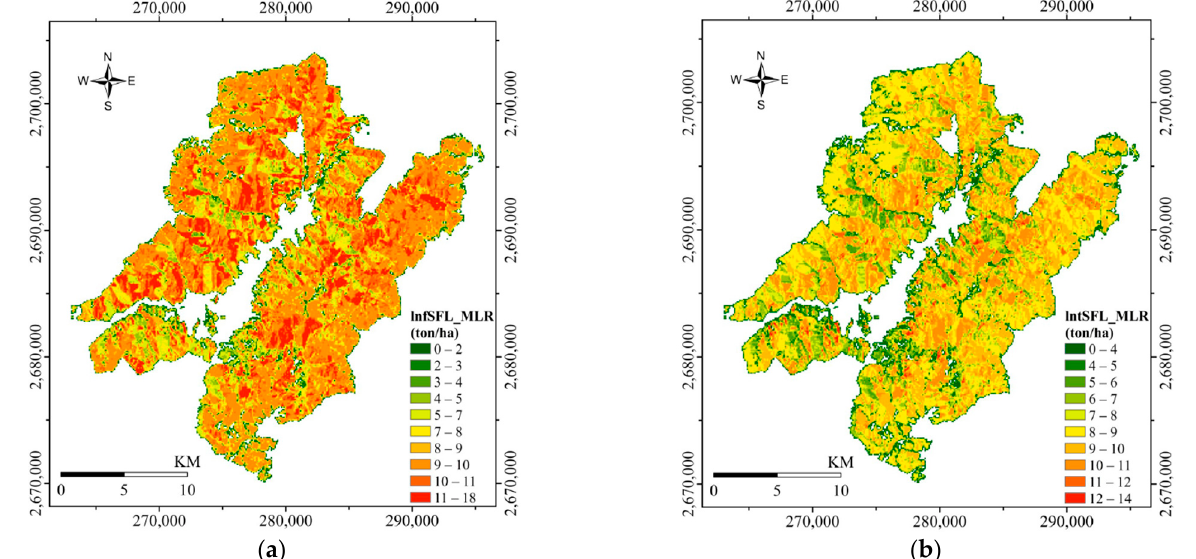
Figure 6. The surface fuel loading regression model-derived fSFL map ( a ) and tSFL map ( b ) of the Dajiaxi National Forest.